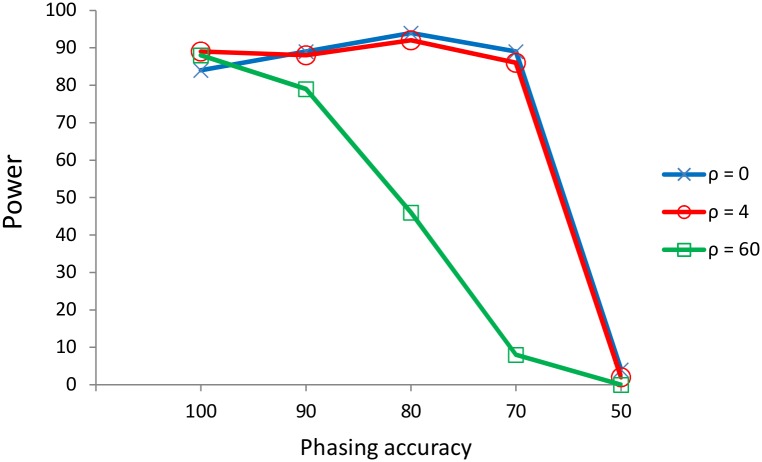
Effect of % phasing accuracy on the power of the nvdFST test.